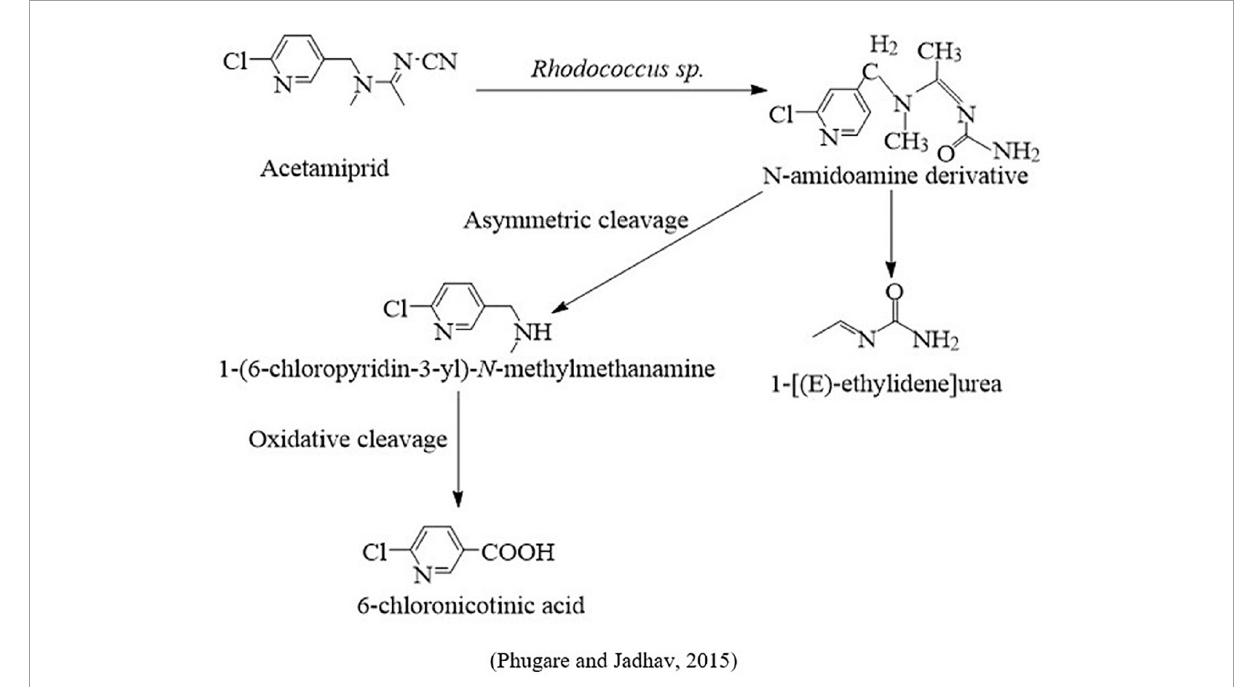
FIGURE4 Microbial metabolic pathway of acetamiprid degradation by insect gut